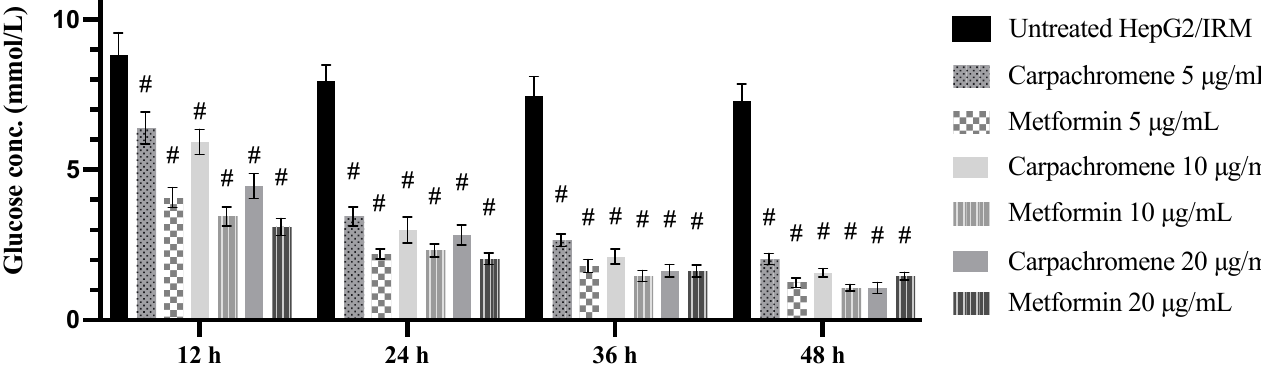
Figure 3. Glucose concentration in the media after treatment of HepG2/IRM cells with carpachromene or metformin at the concentrations of 5, 10, and 20 μ g/mL for 12, 24, 36, and 48 h. Bars represent mean ± SD. Significant difference was analyzed by two-way ANOVA test followed by post hoc Dunnett test, where # p < 0.001, compared to untreated HepG2/IRM cells.